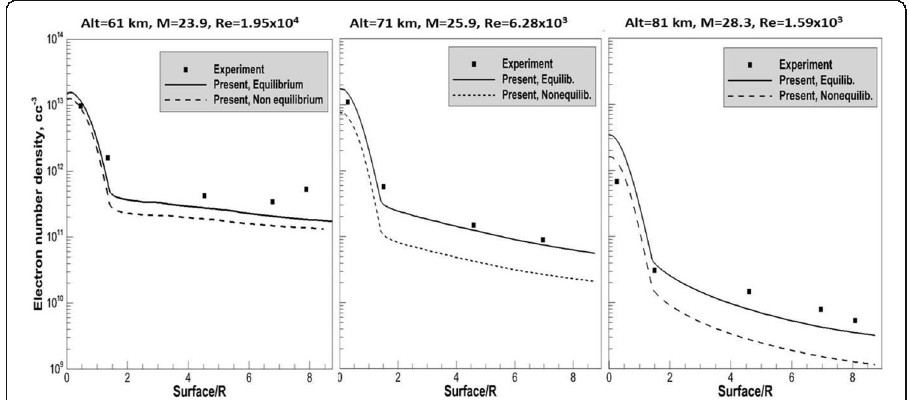
Fig. 16 verification of electron number density by flight data from RAMC-II